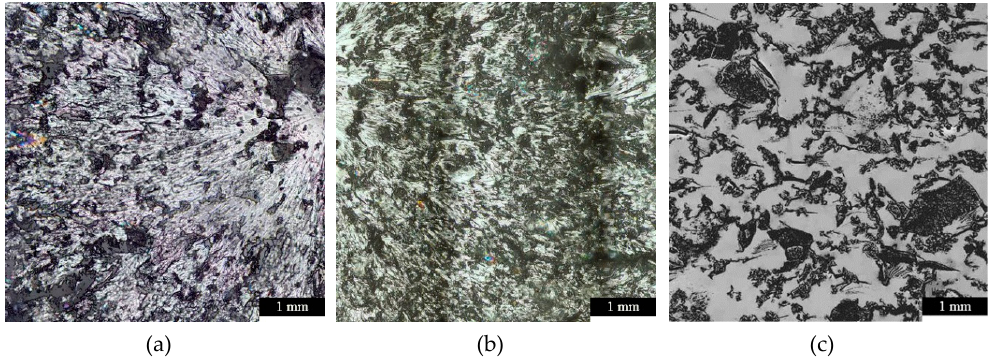
Figure 6. Different effects of mixing methods, ( a ) electromagnetic mixing (EMM) at lower shearing, ( b ) mechanical mixing (MM) at higher shearing, ( c ) ultrasonic mixing (USM).